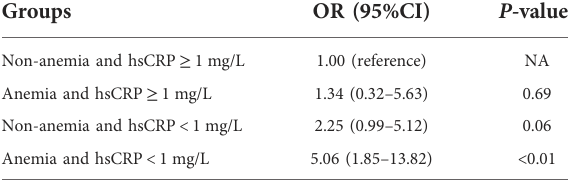
TABLE 4 Risk of AKI strati fi ed by anemia and hsCRP. Groups OR (95%CI) P -value a